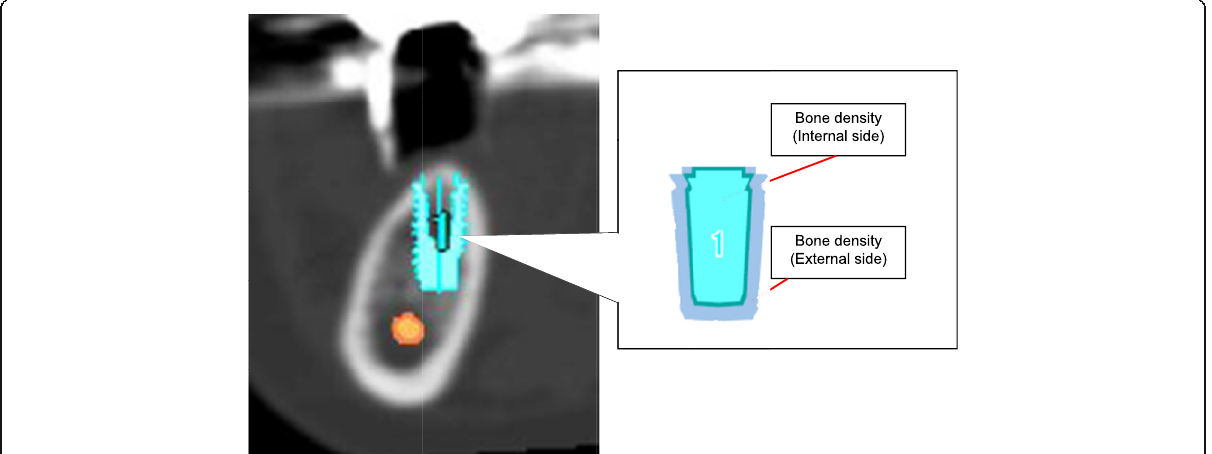
Fig. 1 Measurements on computed tomography (CT) images. The imaging data are stored in Digital Imaging and Communications in Medicine format and loaded into an implant planning software program (Simplant®, Dentsply Implants, Leuven, Belgium). Buccopalatal or buccolingual cross-sectional CT slices are used to measure the bone density at the implant placement sites in Hounsfield units. The mean internal and external side values are used as the bone densities